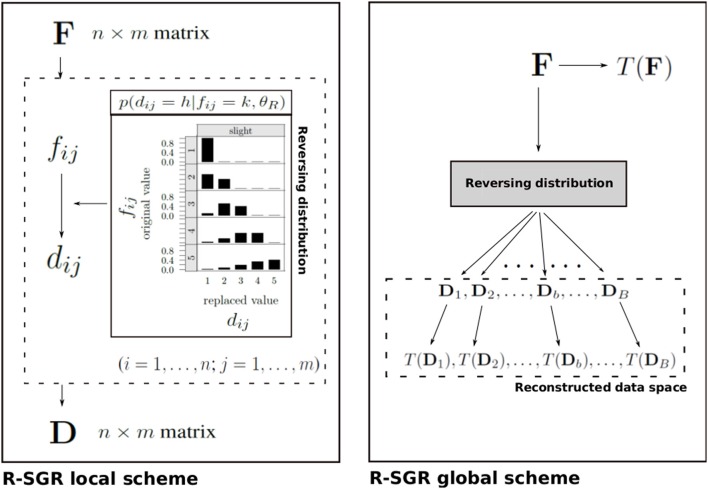
Overall structure of the R-SGR procedure. (Left panel) The R-SGR local scheme describes the generation of a reconstructed (n × m) true data matrix D on the basis of an observed (n × m) fake data matrix F with dij and fij being the (i, j)-entry of D and F, respectively. In this local scheme the reversing distribution (see Equation 2 in the text) is separately applied to each (i, j)-entry of F and mimics a slight faking good process. (Right panel) The R-SGR global scheme illustrates how the R-SGR procedure can be used to generate a simulated reconstructed data space as well as a corresponding simulated space of statistical outcomes T(Db) on the basis of a target statistic T. T(F) is the statistical outcome computed on the observed data F.